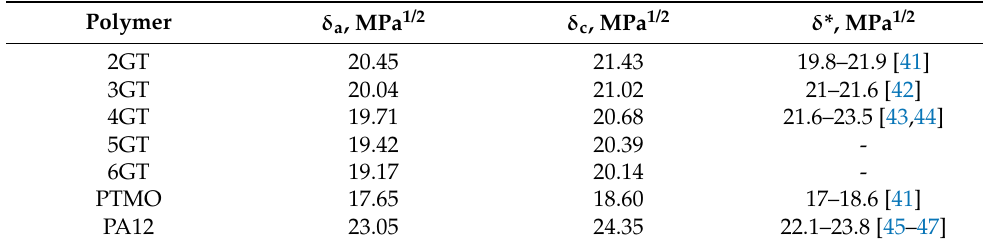
Table 6. The properties of TPE with variable chemical structure of the ester block.